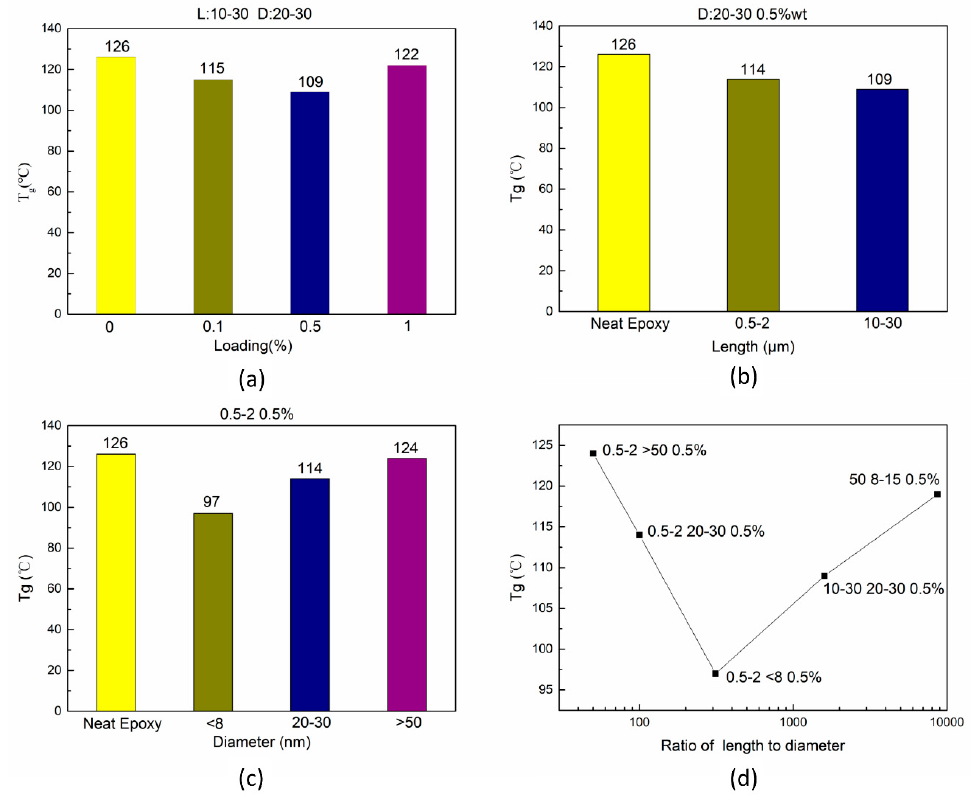
Figure 9. Th relationship between T g and loading ( a ); length of MWCNTs ( b ); and diameter of MWCNTs ( c ); the ratio of length to diameter ( d ).